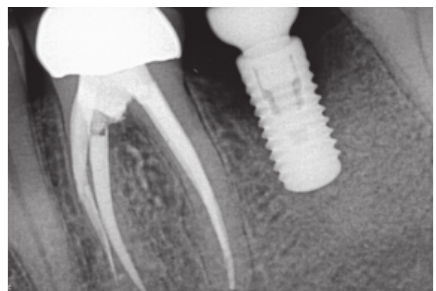
Figure 17: Presence of peri-implant bone loss.